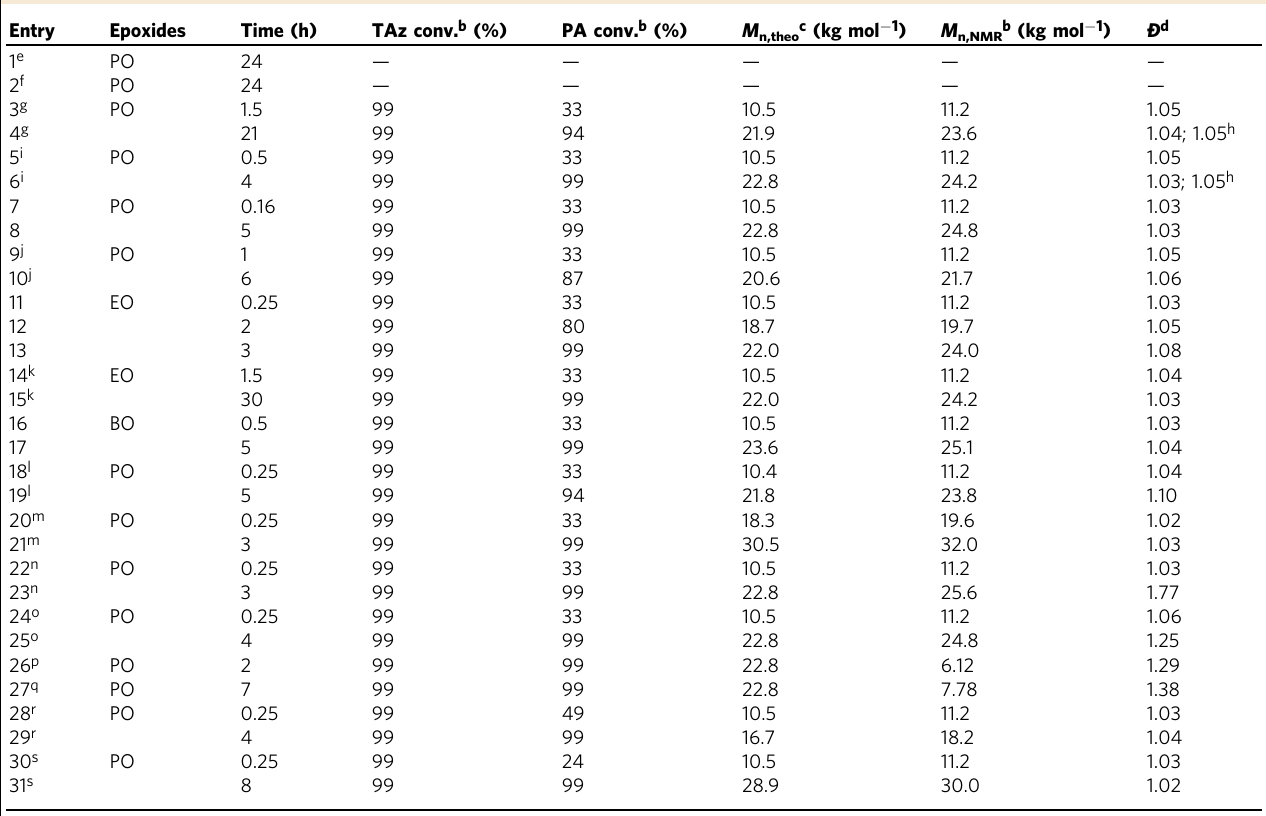
Table 1 Terpolymerization of TAz, PA, and epoxides using t -BuP 1 as a catalyst a .